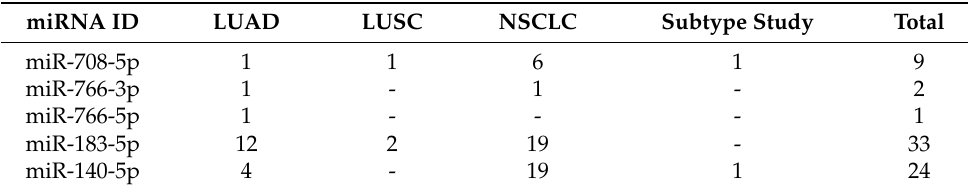
Table 3. The literature search result of miRNA